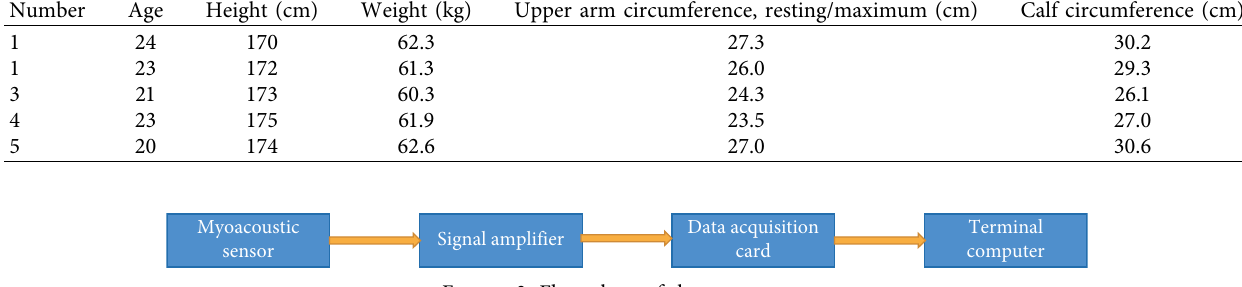
Figure 3: Flow chart of the test system.